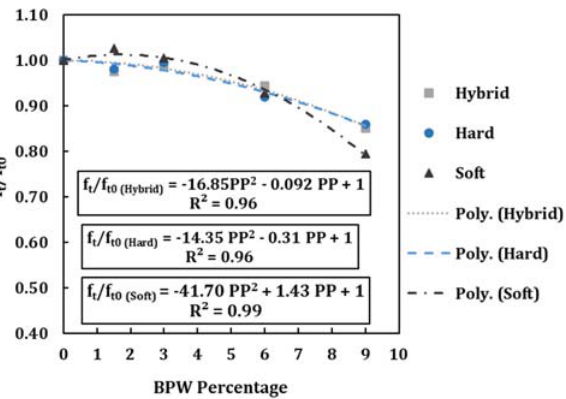
Figure 9. The tensile strength ratio of BPW-containing concrete to control concrete versus BPW percentages.